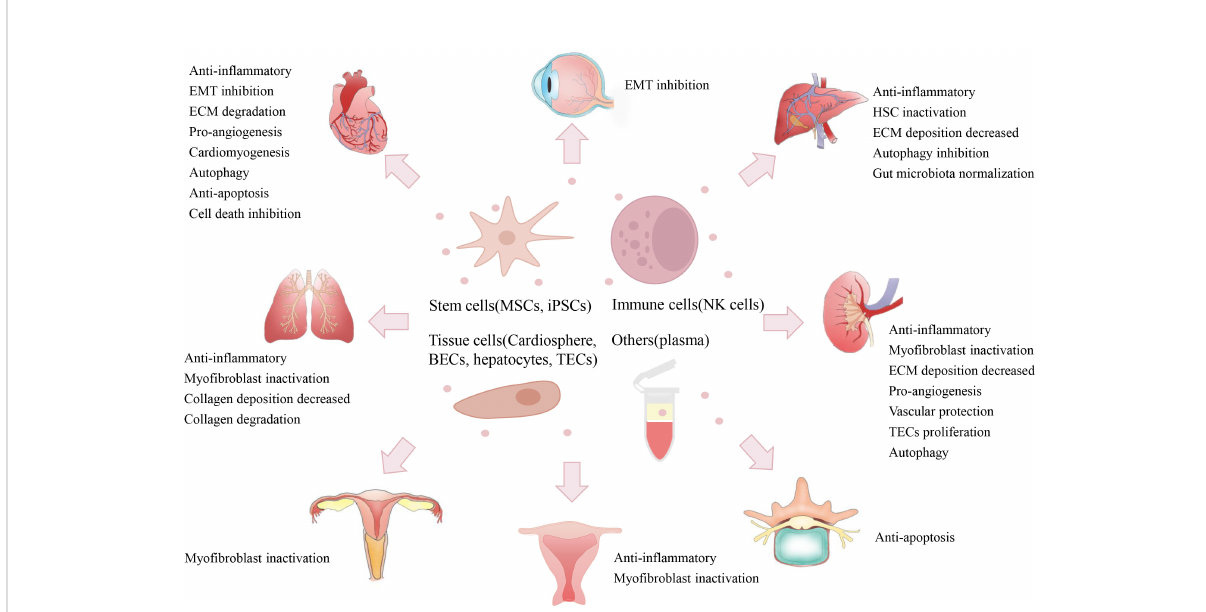
FIGURE 4 Therapeutic potentials of native EVs. Native EVs isolated from multiple cell sources ( e.g. , stem cells, immune cells, tissue cells, and plasma) have exerted therapeutic ef fi cacy on the alleviation of fi brosis in some major organs ( e.g. , heart, lung, liver, and kidney) and other tissues ( e.g. , IUA, IDD, and urethral stricture), and their therapeutic role may be due to multiple mechanisms, such as anti-in fl ammation, EMT inactivation, ECM degradation, and pro-angiogenesis. (Mesenchymal stem cells, MSCs; iPSCs, induced pluripotent stem cells; natural killer, NK; bronchial epithelial cell, BECs; tubular epithelial cell, TECs; epithelial to mesenchymal transition, EMT; extracellular matrix, ECM; intrauterine adhesion, IUA; intervertebral disc degeneration,